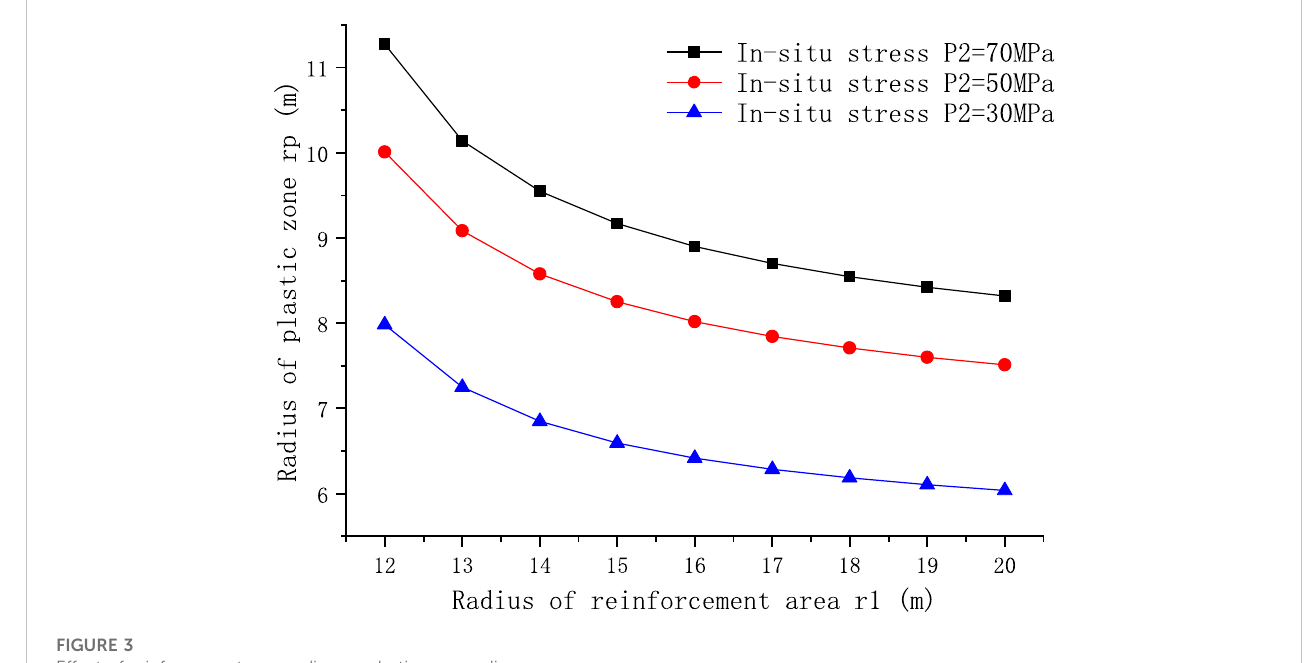
FIGURE 3 Effect of reinforcement area radius on plastic zone radius.